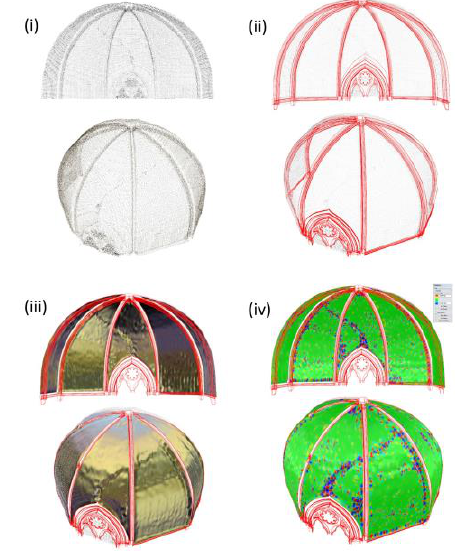
Figure 3. The generative process of the umbrella vault. The post-processing is oriented to give (i) the best version of 3D (cleaned) scan to identify the edges of the main structures easily; (ii) the automatic extraction of geometric primitives allowed (iii) the creation of ultra-detailed NURBS surfaces by GOG 9 and 10, (iv) the Gaussian curvature allow the identification of structural failure and superficial anomalies automatically.